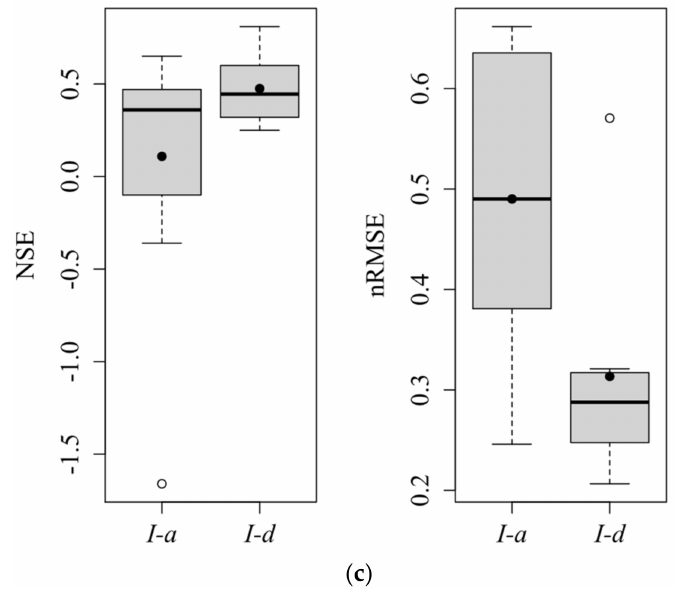
Figure 12. ( a ) Spatial derivation of surface soil moisture at 44 locations. The in-situ soil moisture and modeled soil moisture from I-a and I-d treatments are plotted for six days during the study period. ( b ) Time series of soil moisture simulations at 10 locations. The x-axis denotes the simulation days (Julian days) and y-axis denotes the soil moisture (%). Blue line represents the soil moisture simulations based on I-d experiment while red line denotes the soil moisture simulations based on I-a experiment. Black line represents the in-situ soil moisture. ( c ) Boxplot representation of NSE and nRMSE for the surface soil moisture at the 44 locations. The black dot represents the mean of the data.